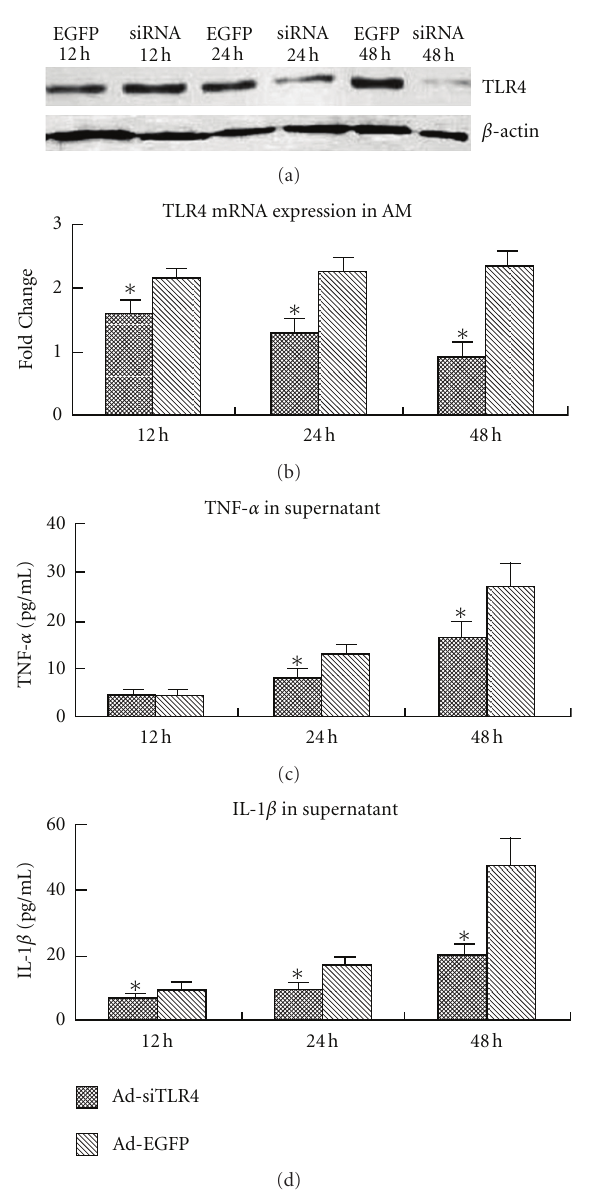
Figure 1: (a) Western blot assay of TLR4 following Ad-siTLR4 or Ad-EGFP pretreatment in LPS treated AMs. (b) Real-time PCR analysis of TLR4 mRNA expression in LPS-treated AMs. (c) and (d) levels of TNF- α and IL-1 β in the supernatant. ∗ P < 0 . 05 versus Ad- EGFP group.